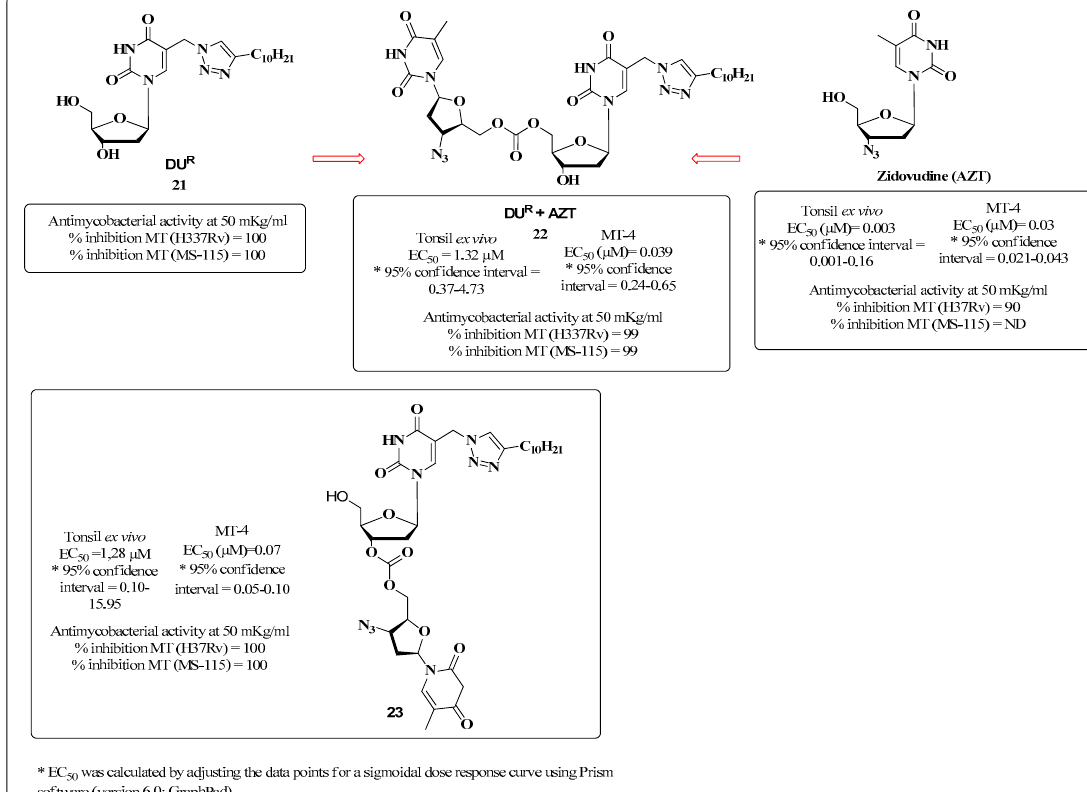
Figure 20. The anti-HIV and anti-MTB activities of Compounds 22 and 23